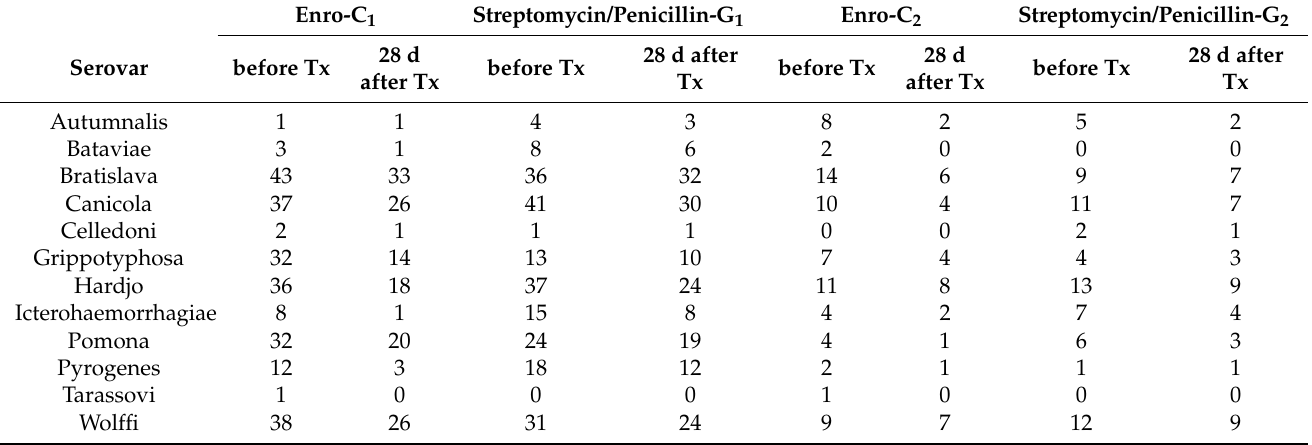
Table 2. Serodiagnosis of leptospirosis by microscopic agglutination test (MAT) before and after treatment with either enro-C or